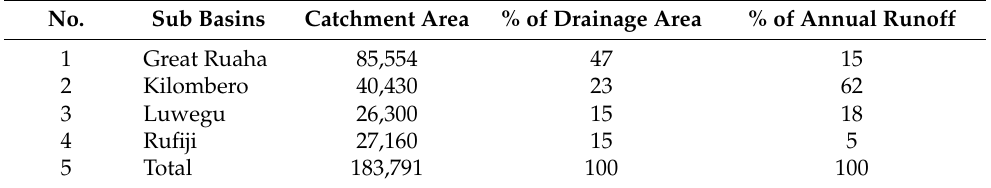
Figure 2. Cross-section of the Kilombero River Catchment adopted from [40]. Table 1. Attributes of the Kilombero river catchment—source